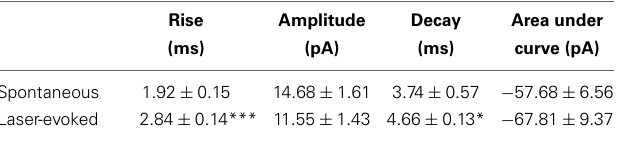
Table 1 | Comparison of spontaneous vs. laser-evoked EPSC events in DRN GABA neurons. Rise Amplitude Decay Area under (ms) (pA) (ms) curve (pA)